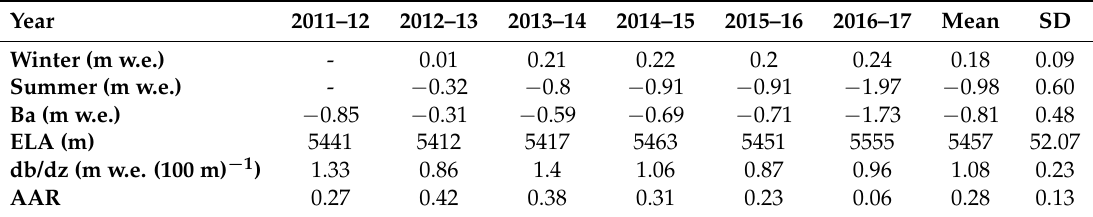
Table 2. Annual glacier-wide mass balances (Ba), winter and summer glacier-wide mass balances, equilibrium line altitude (ELA), accumulation area ratio (AAR) and mass balance gradients (db/dz) for the Yala Glacier with their respective means and standard deviation (SD) from